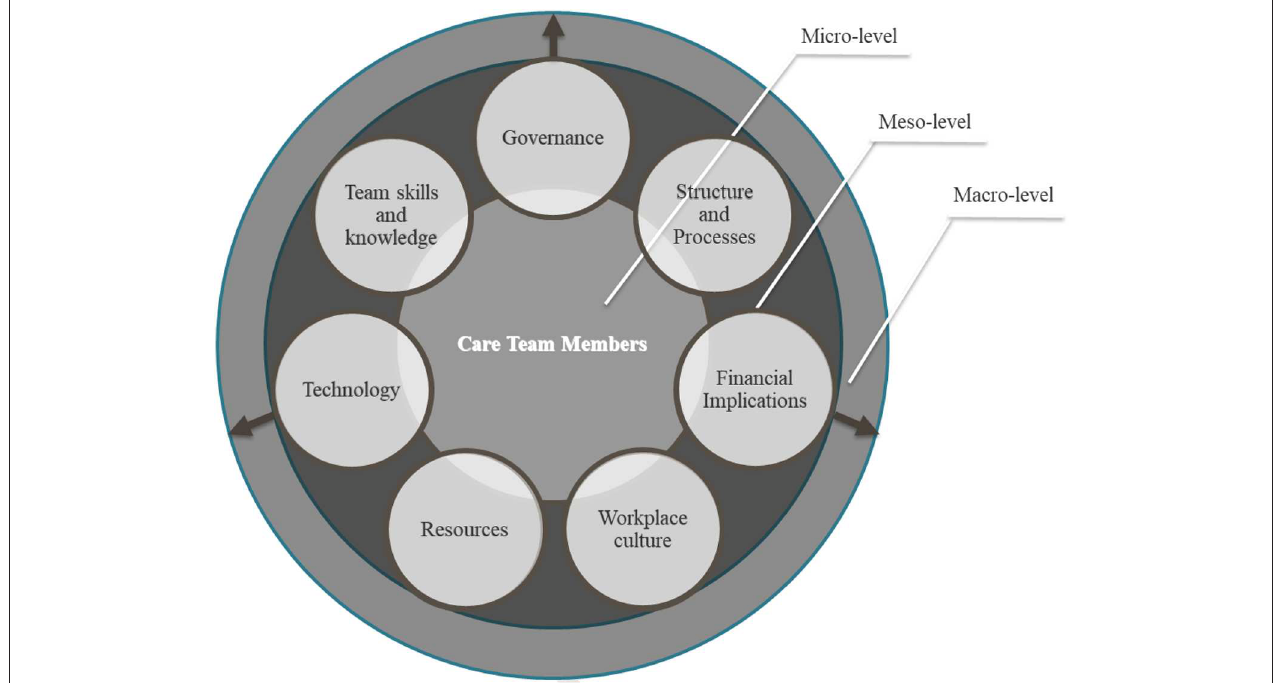
FIGURE 2 | Framework for analysis of organizational factors that impact team-based care.